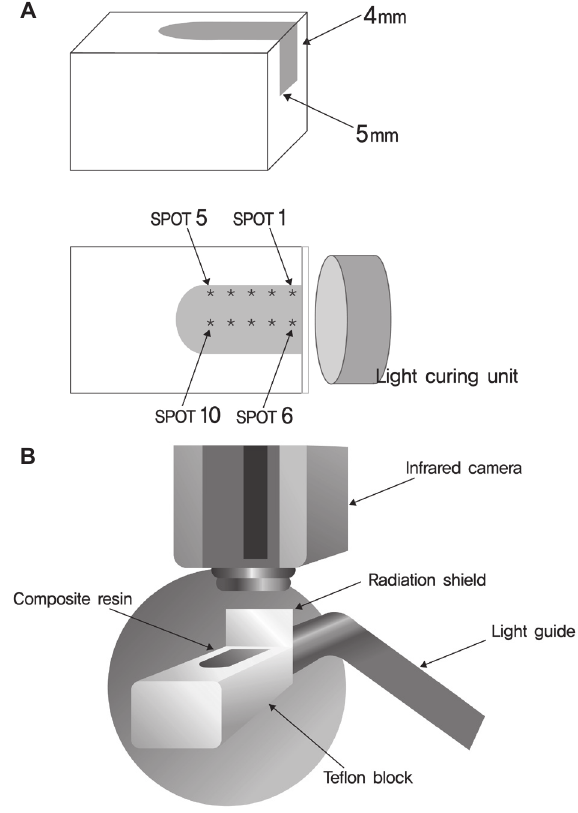
Figure 1- (A) Schematic diagram of the temperature measurement spots from spot 1 to 10. (B) Schematic diagram of infrared thermographic measurement of temperature change in the composite resin during photopolymerization.